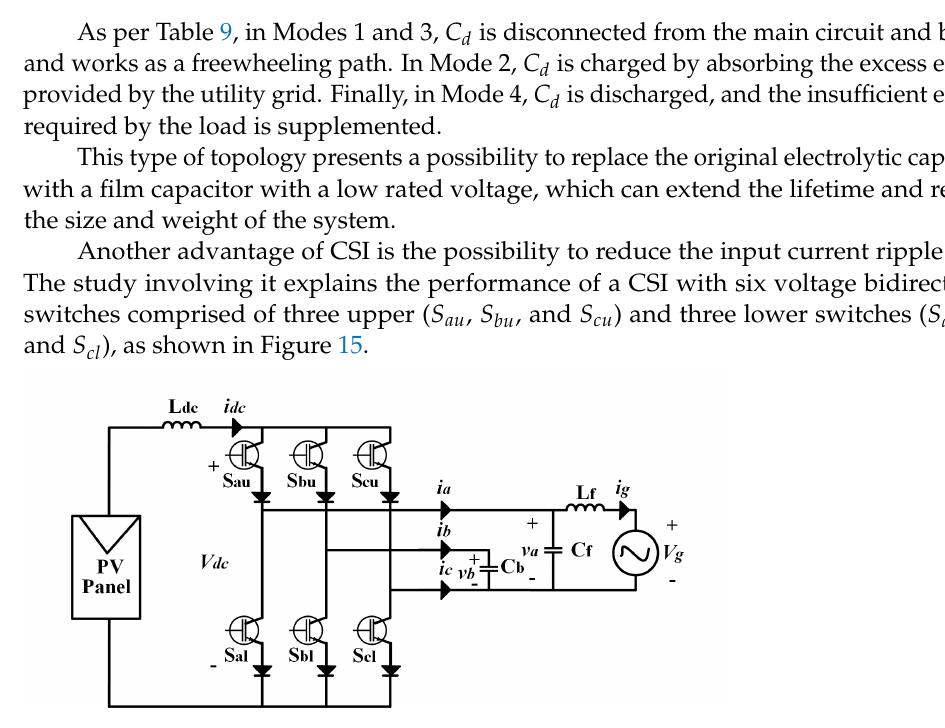
Figure 15. CSI with six voltage bidirectional